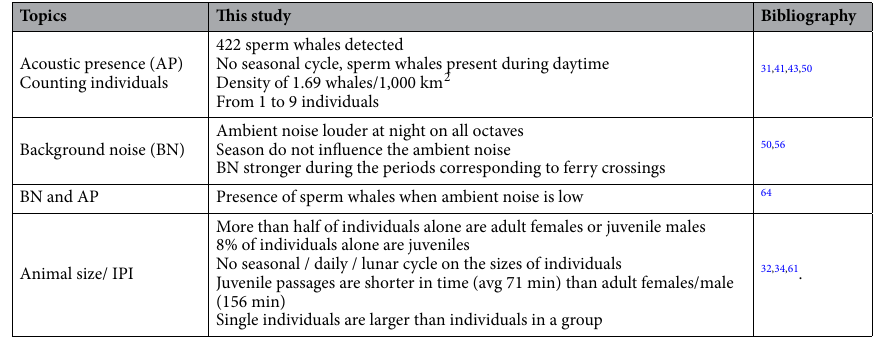
Table 1. Main results of our study associated with the bibliography on the sperm whale population.